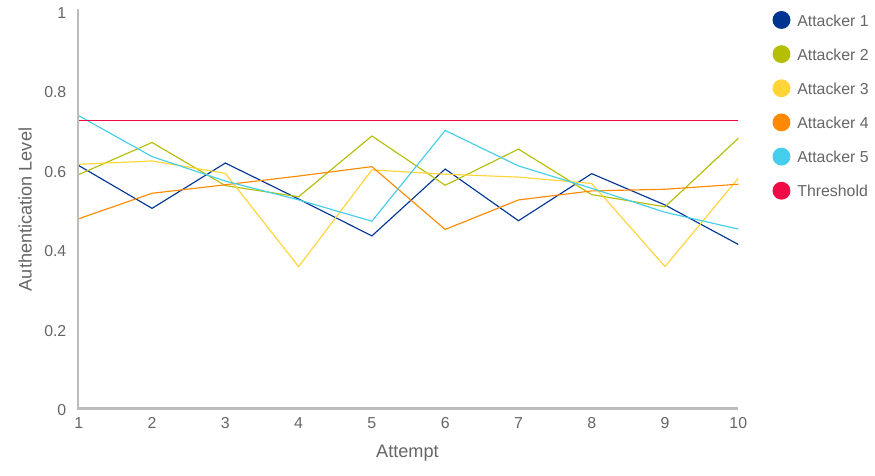
Figure 9. Trial and error attack scores.